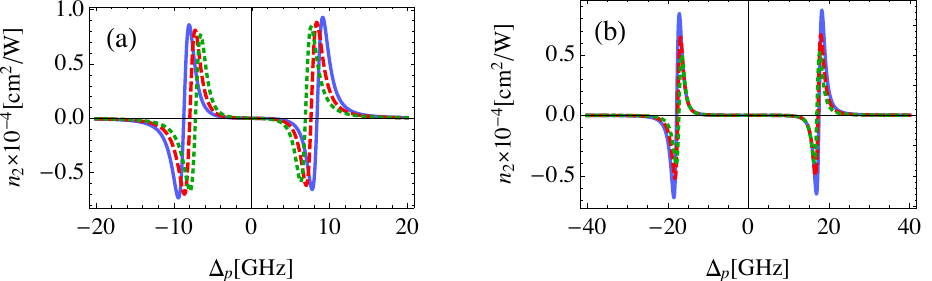
Figure 9. The self-Kerr nonlinear index of refraction for the probe field in the MNP-GND-QD hybrid system of R QG = 12 nm, R GM = 26 nm, θ G = 1 rad, ( a ): θ M = 0.5 rad, R M = 16 nm (solid), R M = 15.5 nm (dashed) and R M = 15 nm (dotted), ( b ): R M = 15 nm, θ M = 0.5 rad (solid), θ M = 0.52 rad (dashed) and θ M = 0.54 rad (dotted). The system is excited with resonant control field of Ω c = 50